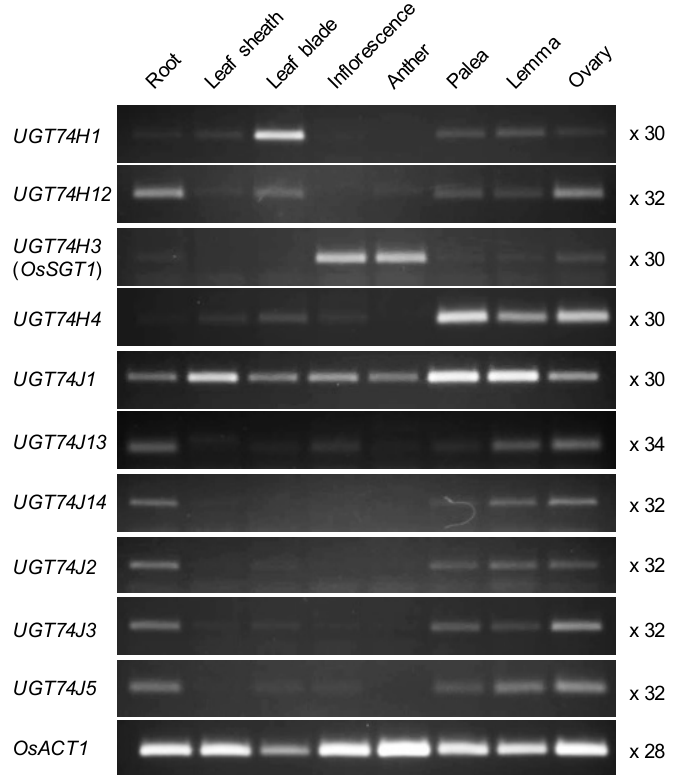
Figure 2. UGT74J1 is a ubiquitously expressed UDP-glucosyltransferase gene in rice. Each tissue was sampled at the following growth stages: root, leaf sheath, and leaf blade were collected from 30-d-old plants; inflorescence and anther were collected from 7- and 9-wk-old plants, respectively; palea, lemma, and ovary were collected from florets on the fifth day after flowering. Semi-quantitative RT-PCR was performed using gene-specific primers, and the cycle number is indicated at right. OsACT1 was used as the endogenous control.